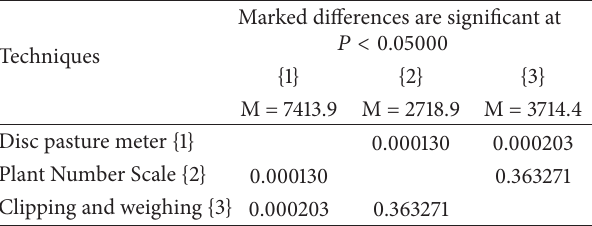
Table 3: Statistical analysis of the differences in phytomass (M = meanphytomass)betweenthethreetechniquesusingtheTukeytest. Marked differences are significant at 𝑃 < 0.05000 Techniques { 1 } { 2